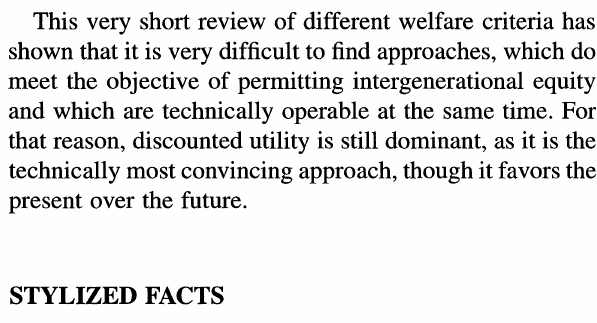
FIGURE The components of resource